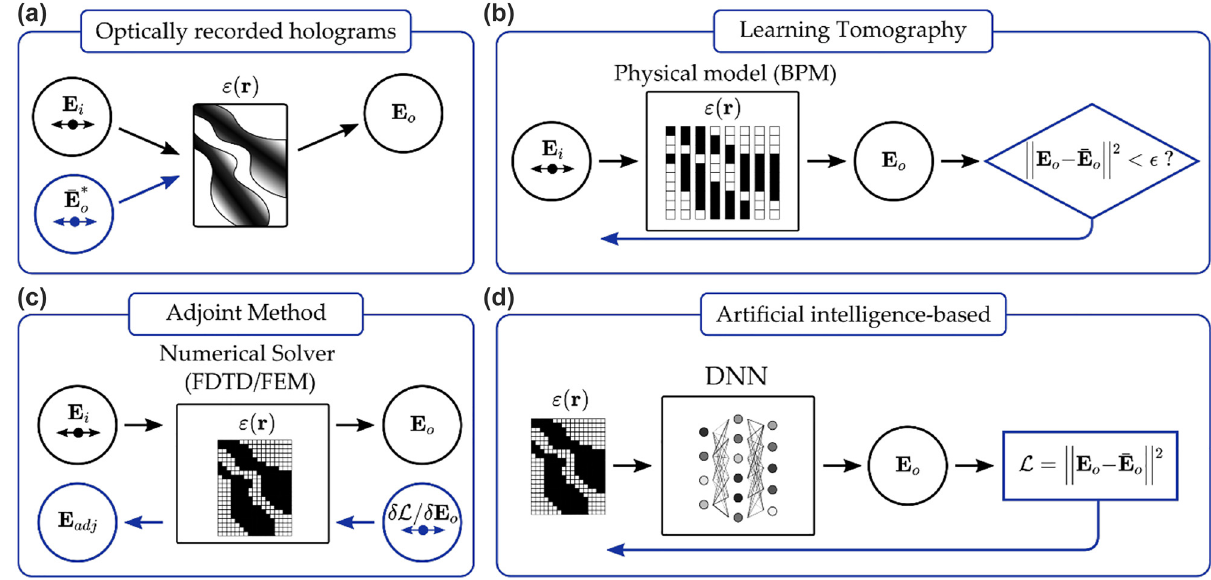
Figure 6: Different approaches for inverse design of volume optical elements. (a) Optically recorded holograms obtained from the interference of (black) and the conjugated objective field E ∗ (blue). (b) Learning tomography. The input field is propagated through the guess incident field E i o structure by BPM (black). The predicted output E is compared with the target field E ∗ and the error is backpropagated to iteratively update the o o structure (blue). (c) Adjoint variable method: the gradients of the objective function with respect to design parameters are computed through two simulations. The forward one (black) and the adjoint in which the source depends on the original fields and objective function and the corresponding time-reversed simulation (blue). (d) AI-based methods: a DNN maps the relationship between permittivity and output fields (black). The loss is computed as in (b) and backpropagated through the network